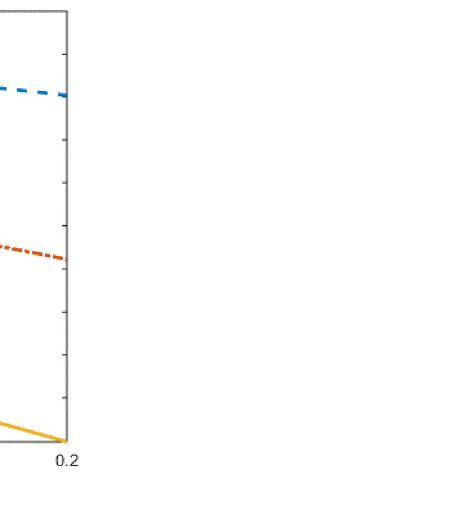
Figure 8. Results of γ and φ on Skin friction coefficient.